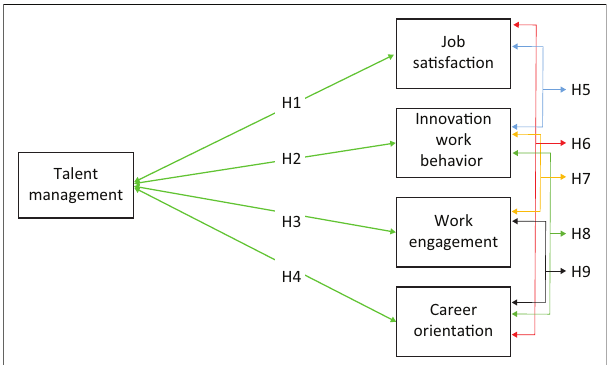
FIGURE 1: A hypothesised model for the